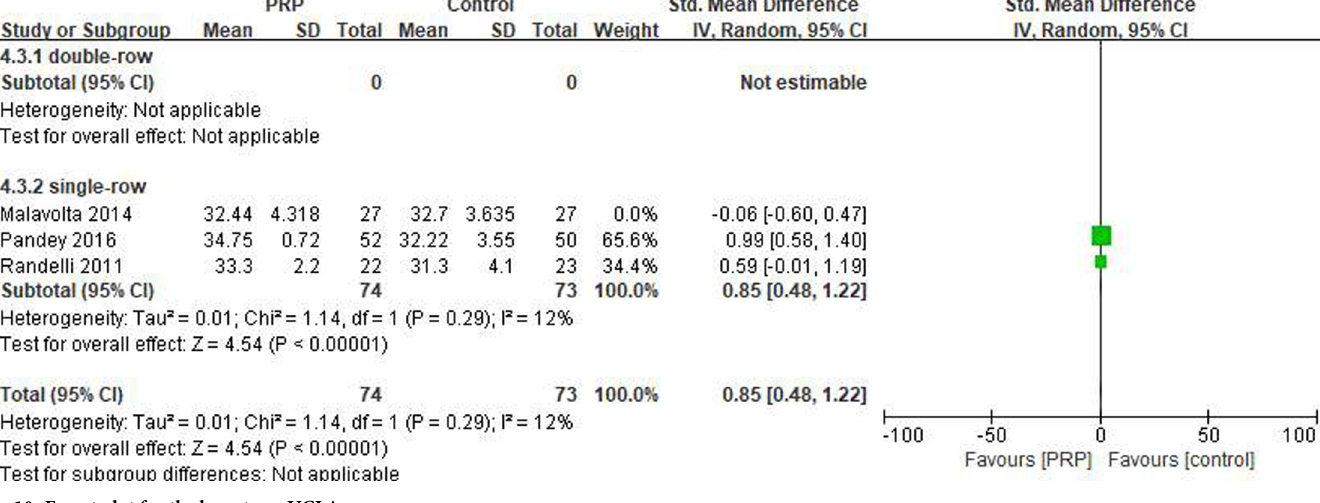
Fig 10. Forest plot for the long-term UCLA score.